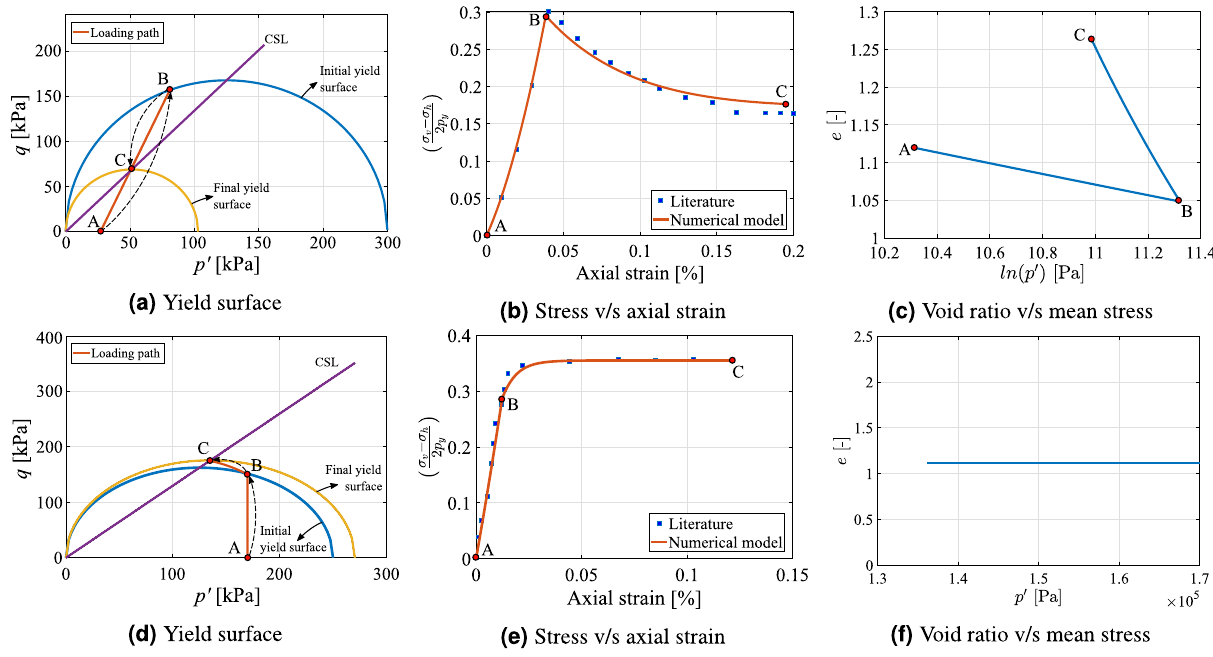
Figure 5. benchmarking: illustration of the strain softening scenario using MCC with consistency condition for drained rock (Fig. 5 a – c ) and strain hardening scenario for undrained rock (Fig. 5 d – f ) respectively. The simulation results are compared with 86